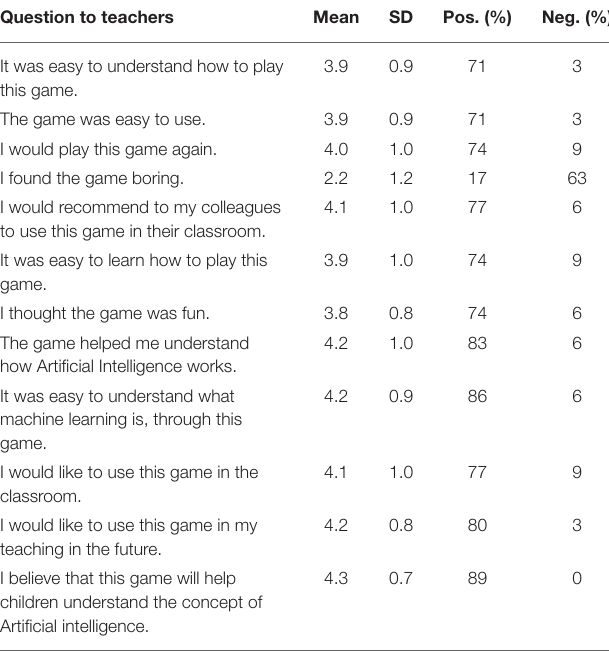
TABLE 3 | Likert scale questions asked to the teachers in the survey. Scores ranged from 1 (strongly disagree) to 5 (strongly agree). Question to teachers Mean SD Pos. (%) Neg.